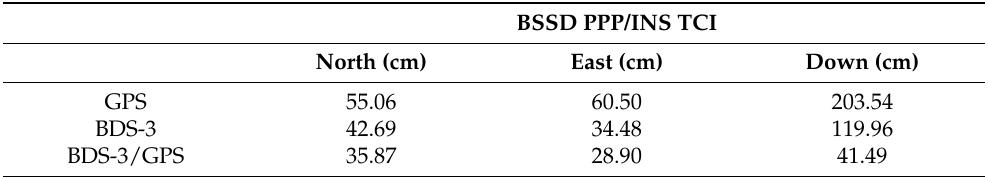
Figure 7. Positioning errors of BSSD PPP/INS TCI with different GNSS. Table 3. Position RMS of BSSD PPP and BSSD PPP/INS TCI with different GNSS.